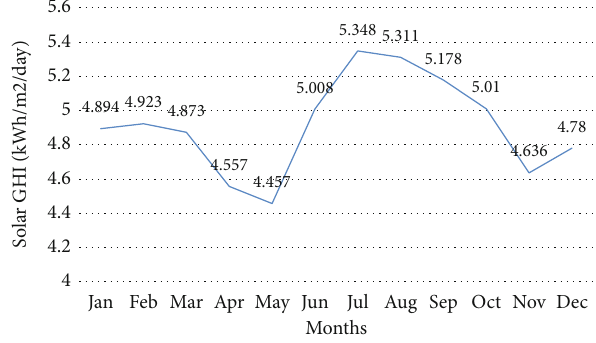
Figure 7: Monthly solar Global Horizontal Irradiation (GHI kWh/m 2 /day) for Uganda.